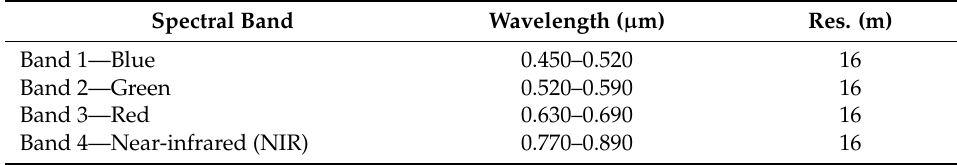
Table 2. The bandwidth and spatial resolution of the GF1-WHU